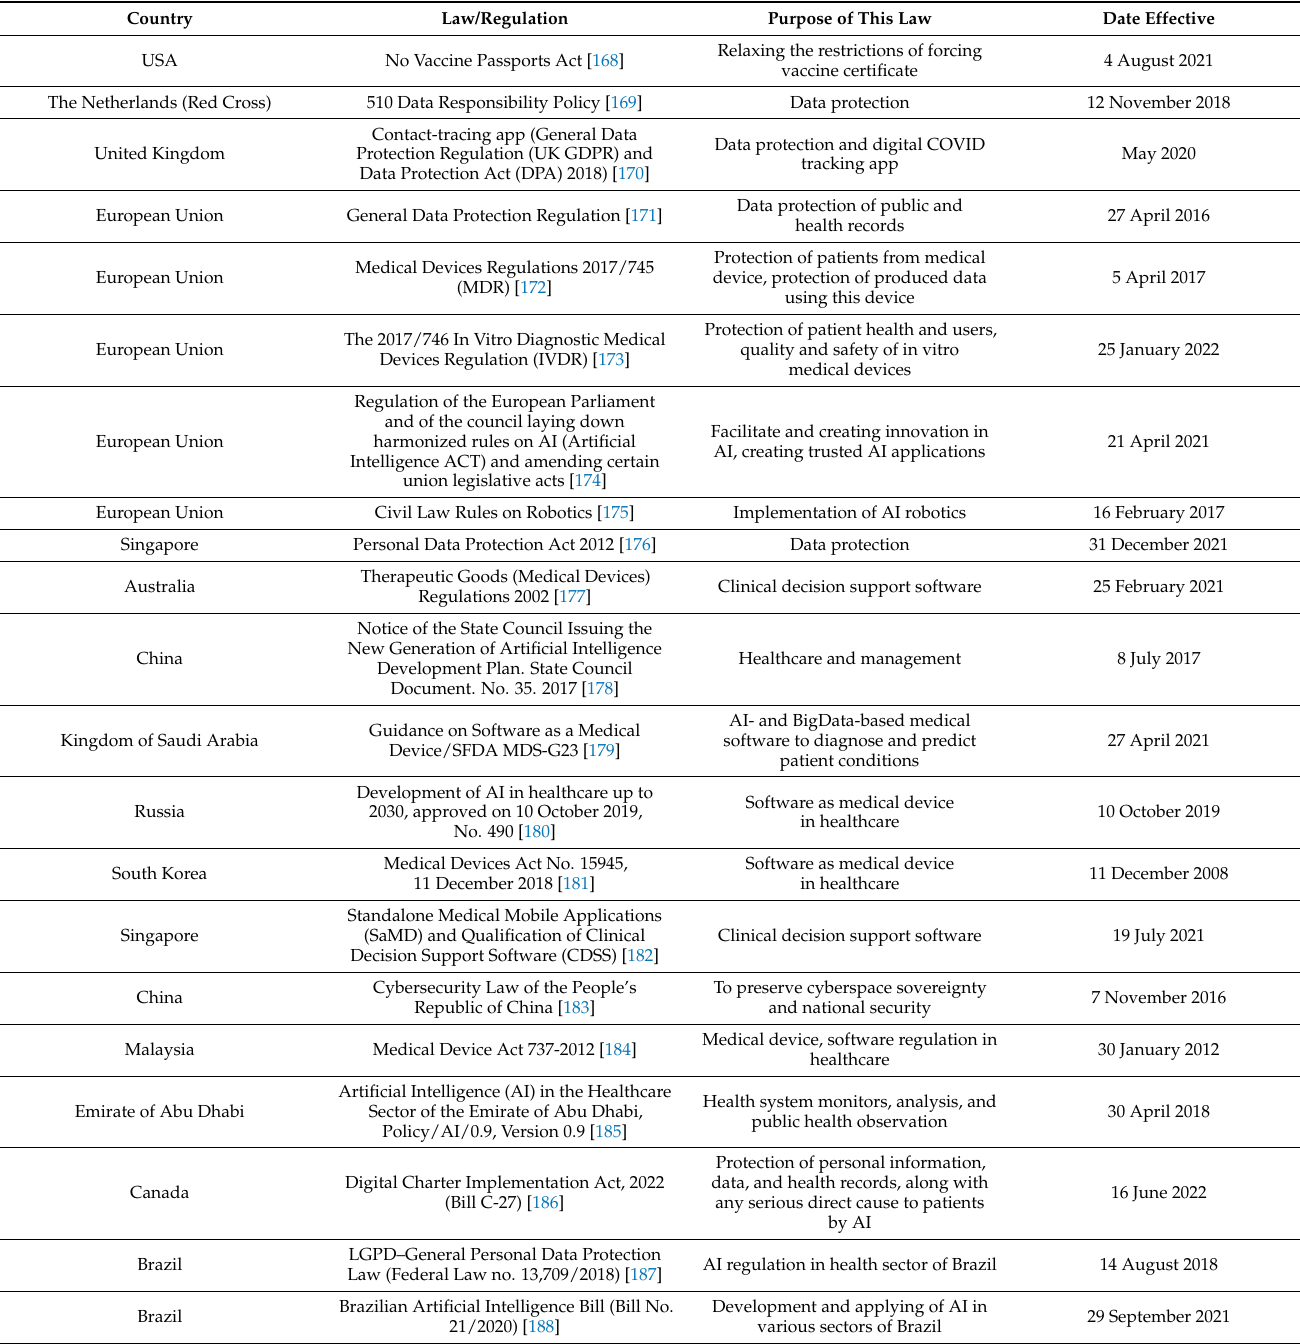
Table 4. Laws and regulations implemented based on AI healthcare in various countries past and present regarding the